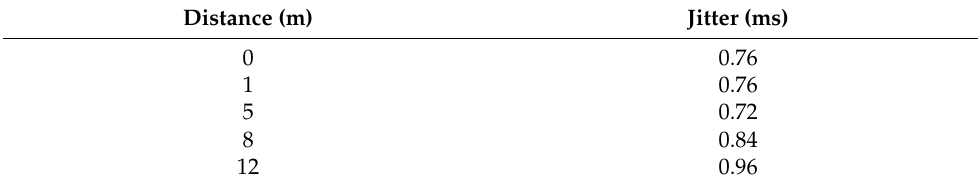
Table 3. Reception jitter at three different Smart Measuring Nodes at different distances.